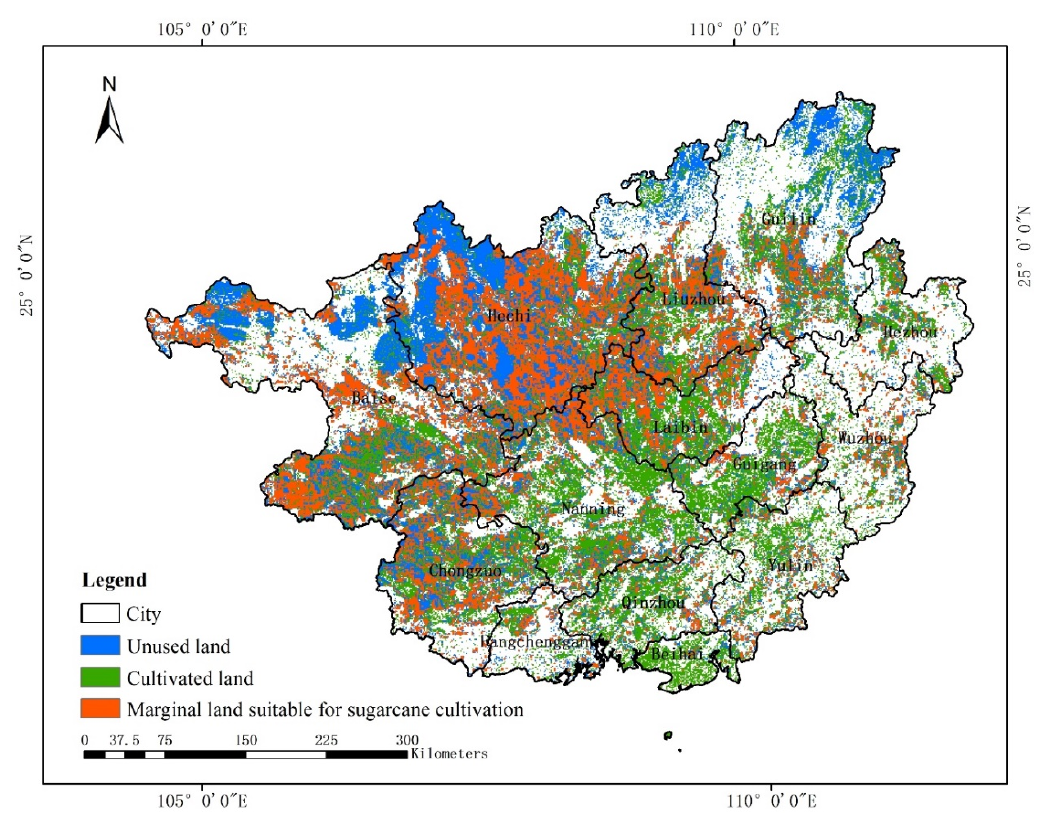
Figure 4. Spatial distribution of marginal land suitable for growing sugarcane, cultivated land, and remaining unused land in the Guangxi Zhuang Autonomous